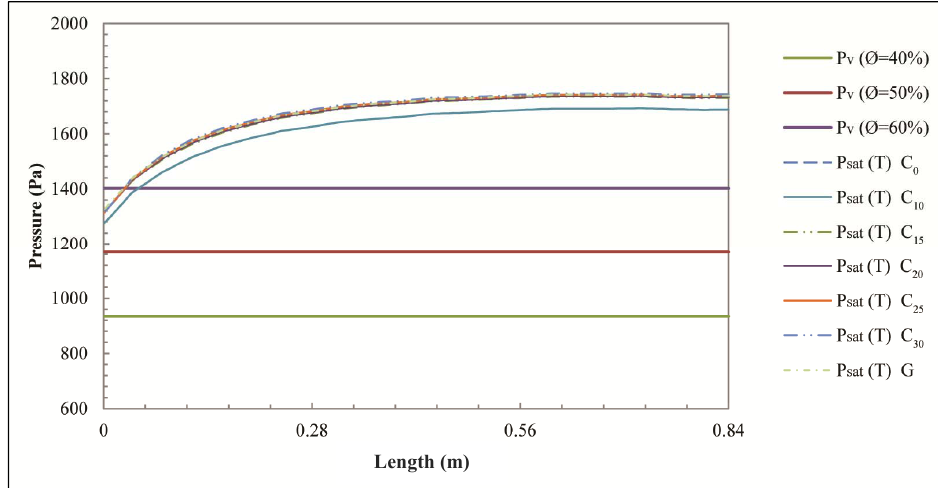
Figure 14. Partial pressure of vapor and saturation pressure of water on the corner between wall and slab (corner “a” of Figure